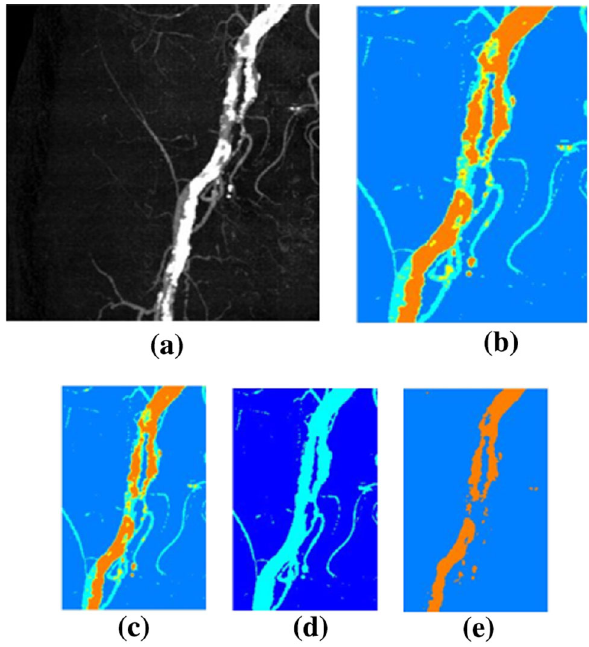
Fig. 5 Example of segmentation applied on RoI: a native CT image RoI, b , c multilevelsegmentationmethod(foursegmentationclasses), d physiological part of blood vessel, and e extracted area of calcifications